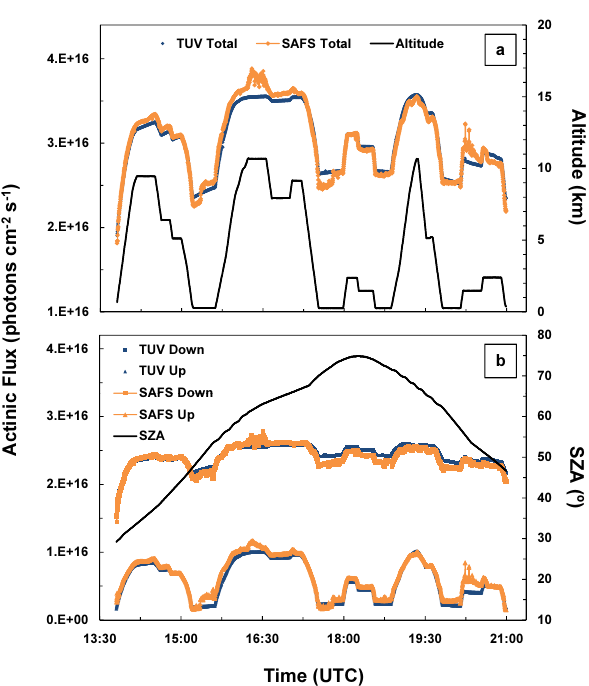
Fig. 1. Time series of measured (clear-sky) and cloud-free mod- eled (a) total and (b) down-welling and up-welling actinic flux for 13 August. Aircraft altitude and SZA variations are also shown in panels (a) and (b) , respectively.